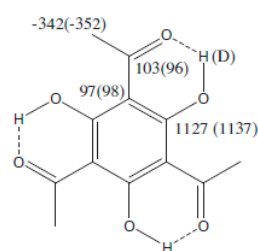
Figure 17. Tautomeric equilibrium of the Mannich base based on 2-hydroxy-3,4,5,6-tetrachloroben-